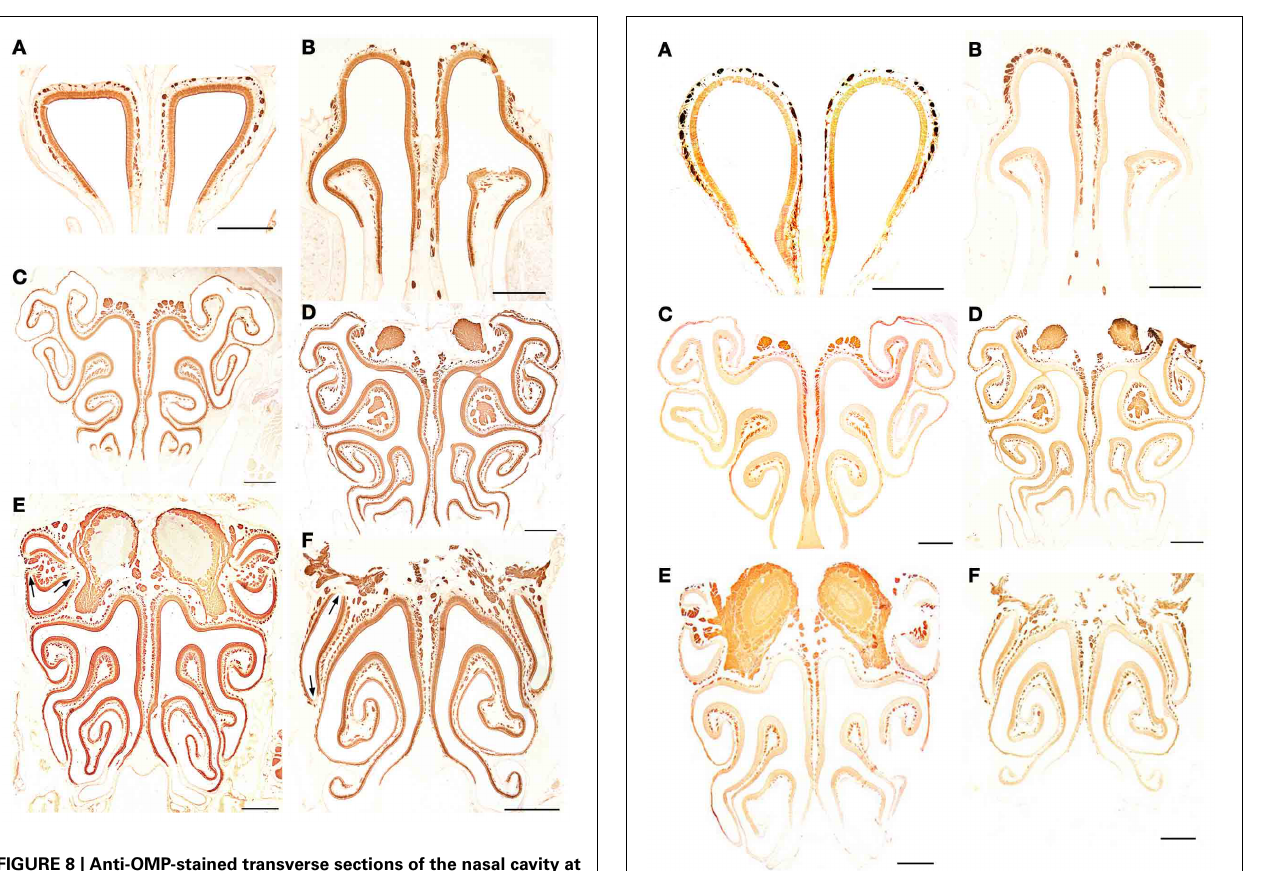
FIGURE 8 | Anti-OMP-stained transverse sections of the nasal cavity at the central levels of the vomeronasal organ (A) and septal organ (B), and at the same levels as in Figure 4 (C–F). Note the similar reactivities of epithelium and axon bundles. In (E,F) , arrows indicate small areas devoid of immunoreactivity. Scale bars: 500 μ m.